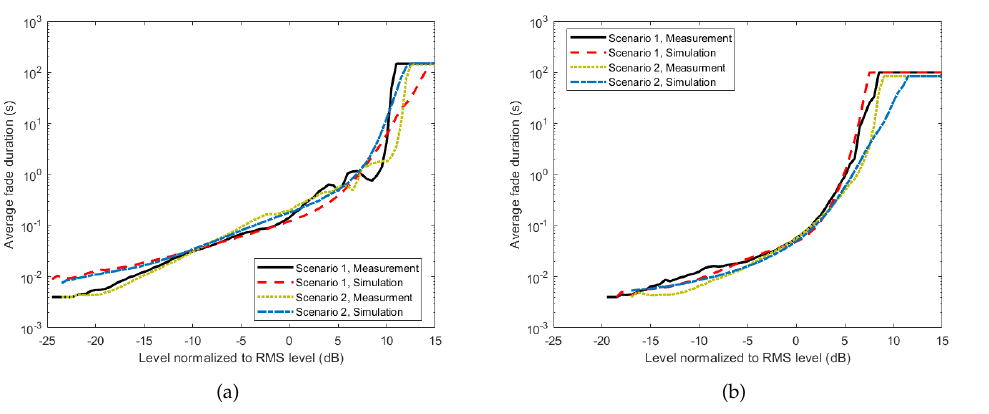
Figure 11. Comparison of AFD of the measurement results, and the developed simulated model results.( a ) running; ( b )